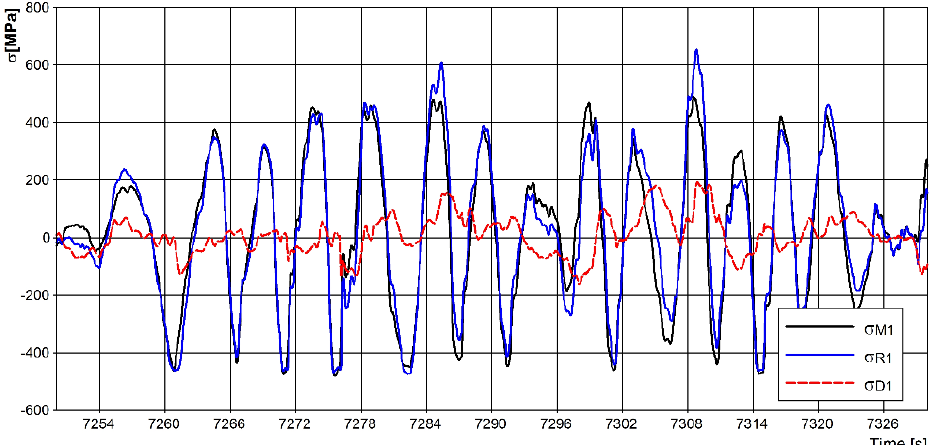
Figure 10. Stress waveform for point C 1 together with symmetric stresses 𝜎 M1 and asymmetric stresses 𝜎 𝐷1 .